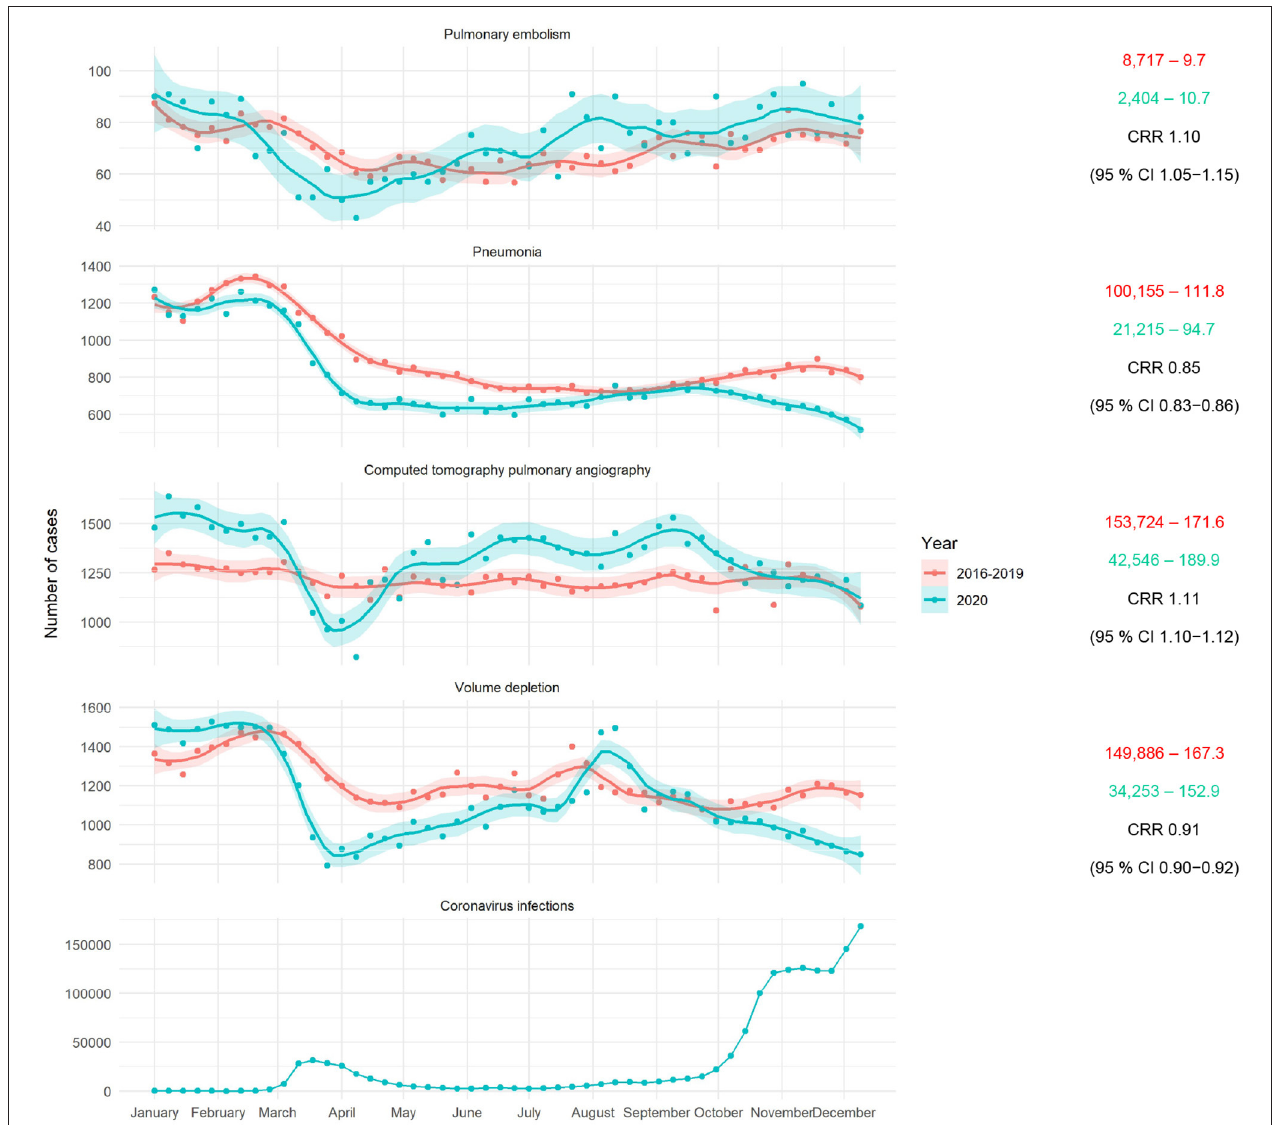
FIGURE 1 | Left: Total weekly hospital admissions for pulmonary embolism, non-COVID-19 pneumonia, CTPA, volume depletion, and new SARS-CoV-2 infections in Germany (from top to bottom). Smooth curves for weekly admission rates were fitted via locally weighted scatterplot smoothing (LOESS) with a degree of smoothing of α = 0.2. Shaded areas represent 95% CI. Right: Total and daily admissions, and resulting CRR with 95% CI between May 6 and December 15, 2020, and the corresponding control period